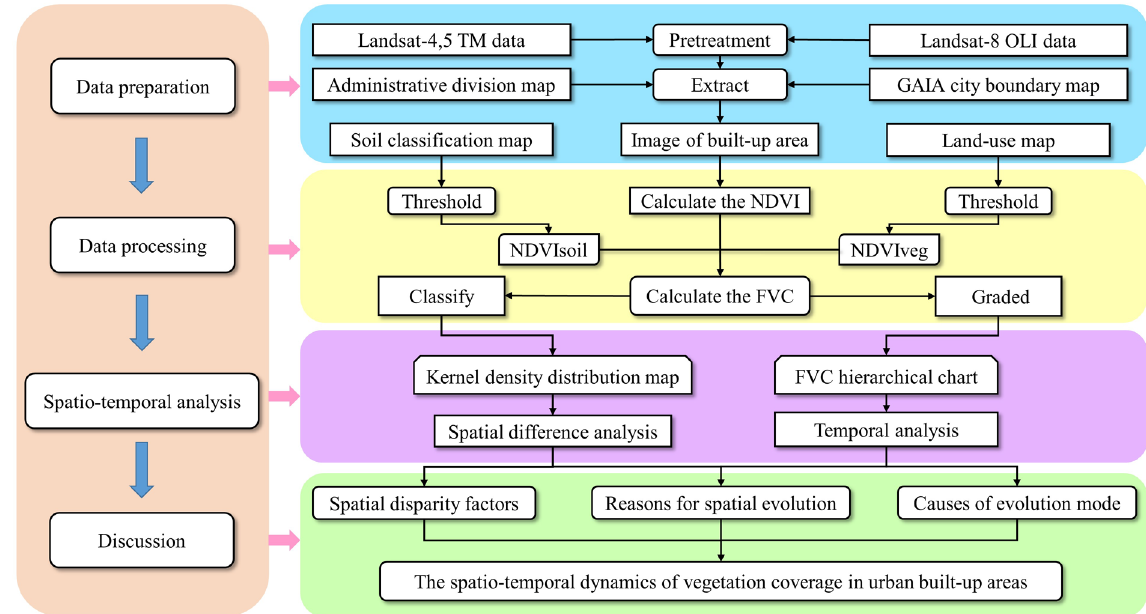
Figure 2. The general workflow of this study.